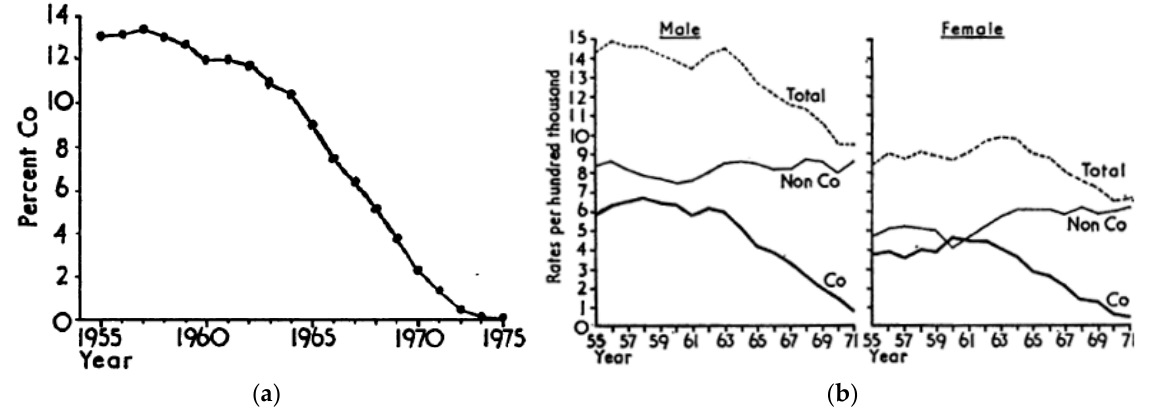
Figure 4. Relationship between residential gas species and suicide rates in U.K.: ( a ) CO percentage in the domestic gas of U.K. ( b ) England and Wales: suicide rates by mode of death [64].